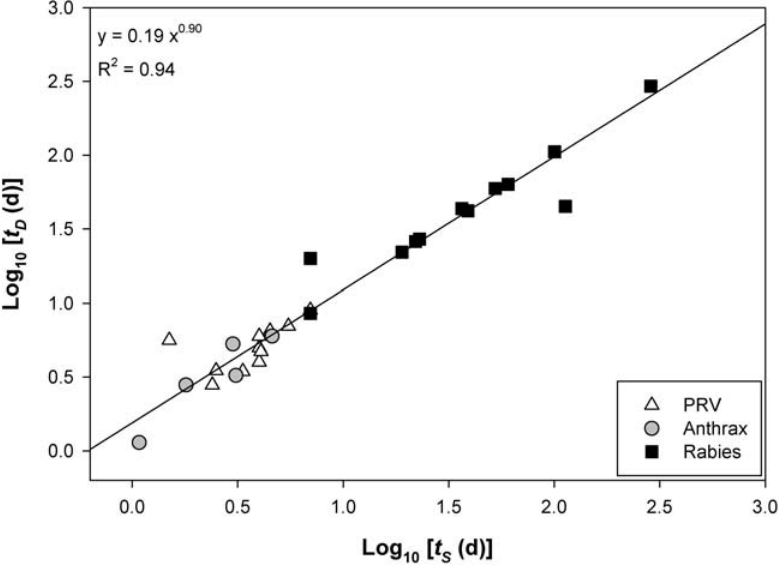
Figure 2. Time (days) from inoculation to death (t D ) versus time from inoculation to 1 st symptom (t S ) for Pseudorabies Virus (PRV), Anthrax, and Rabies for a large range of mammalian body sizes, plotted with the 1:1 line.